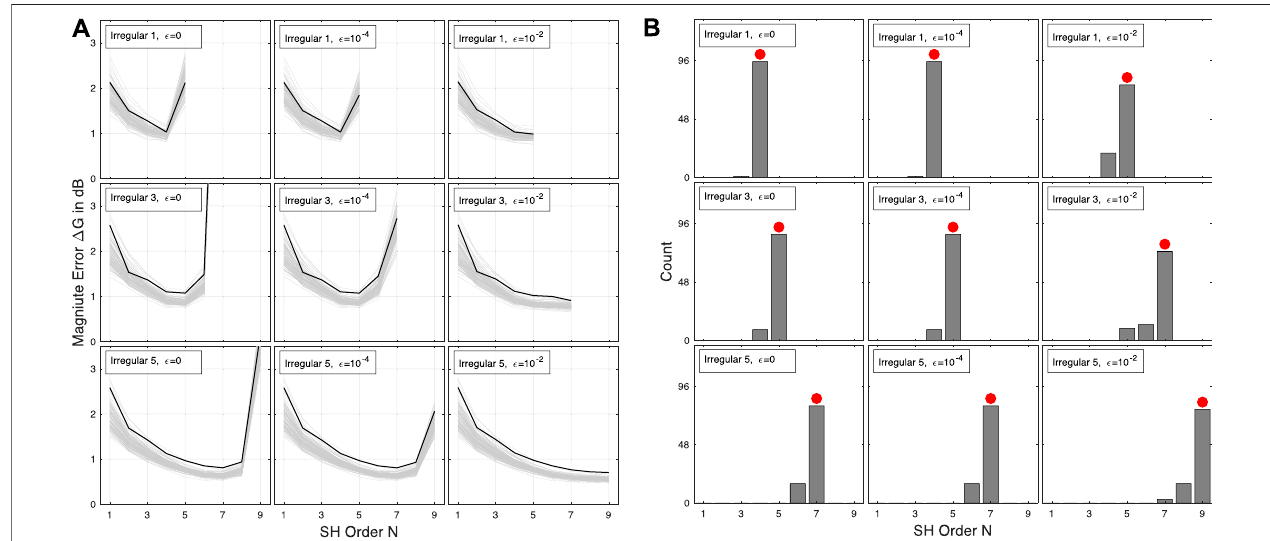
FIGURE 5 | (A) Left-ear magnitude error Δ G with respect to SH order for 96 individual HUTUBS HRTF sets (gray lines) and for the averaged HUTUBS HRTF set (black line) for three examined irregular grids and different regularization values ϵ . (B) Distribution of estimated optimal SH orders from the 96 individual HUTUBS HRTF sets (count as Gy bars) and the averaged HUTUBS HRTF set (red dot).